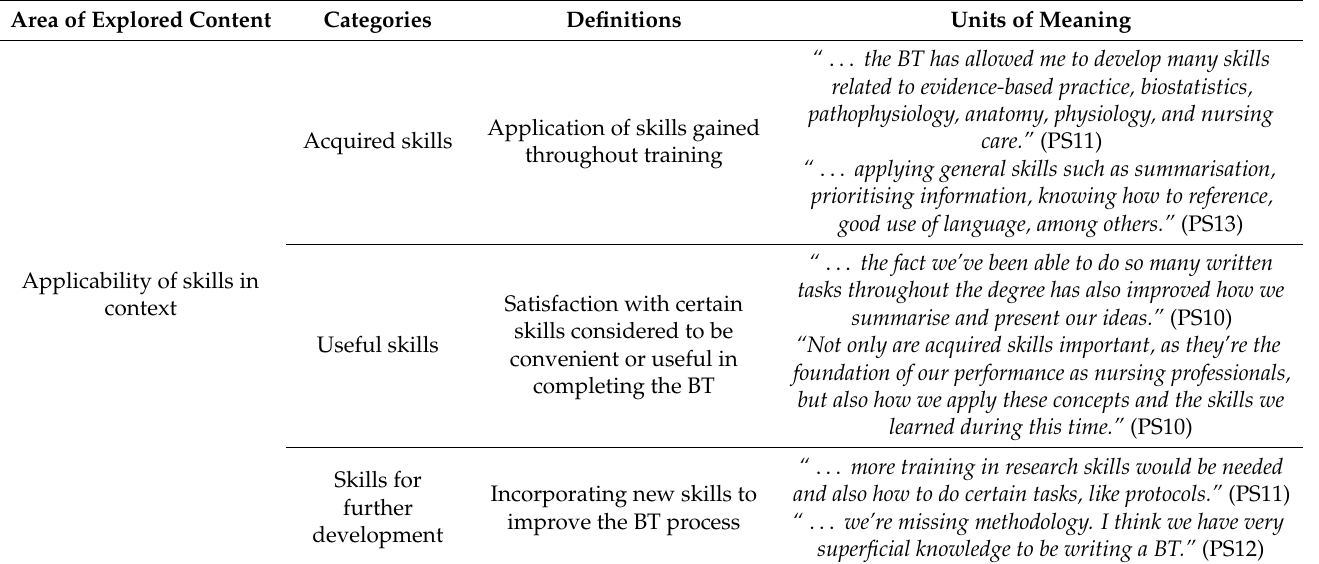
Table 5. Qualitative results matrix, Level 3 (participant student: